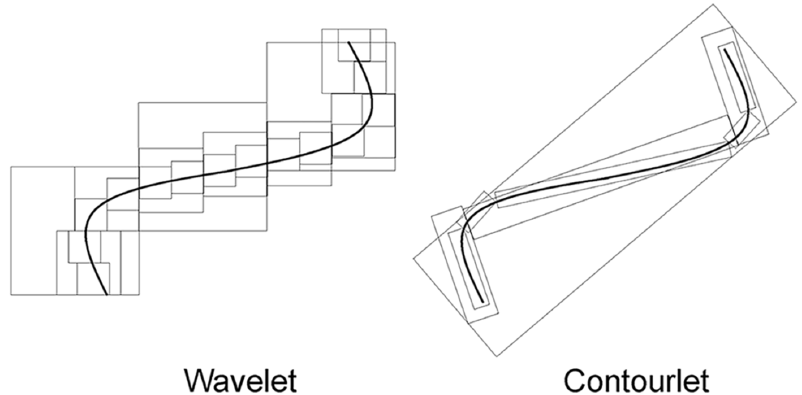
Figure 1. Describing a smooth contour by two different schemes.